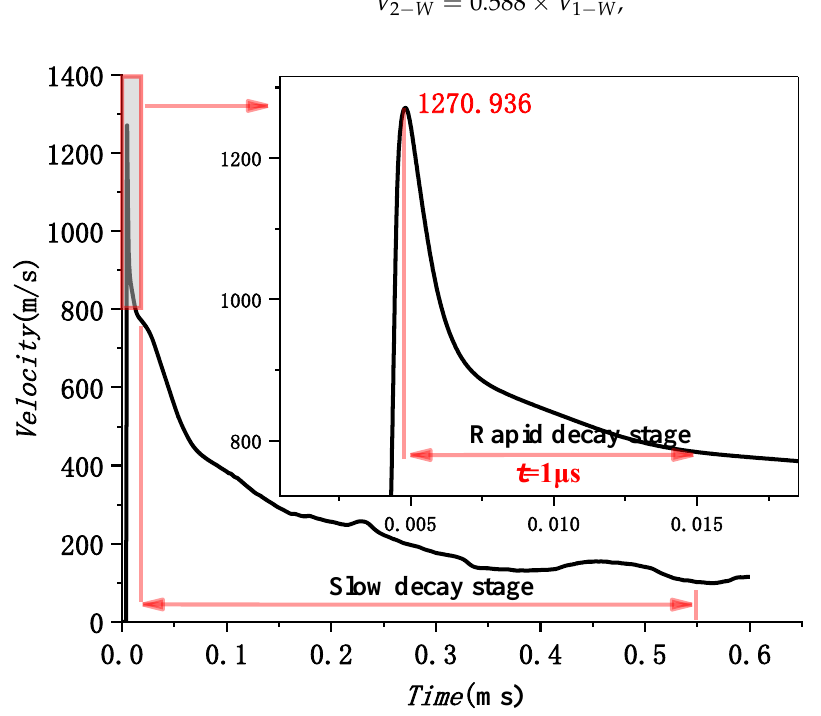
Figure 14. Evolution of velocity of projectile in water without air cavity. Table 8. Velocity attenuation in the second